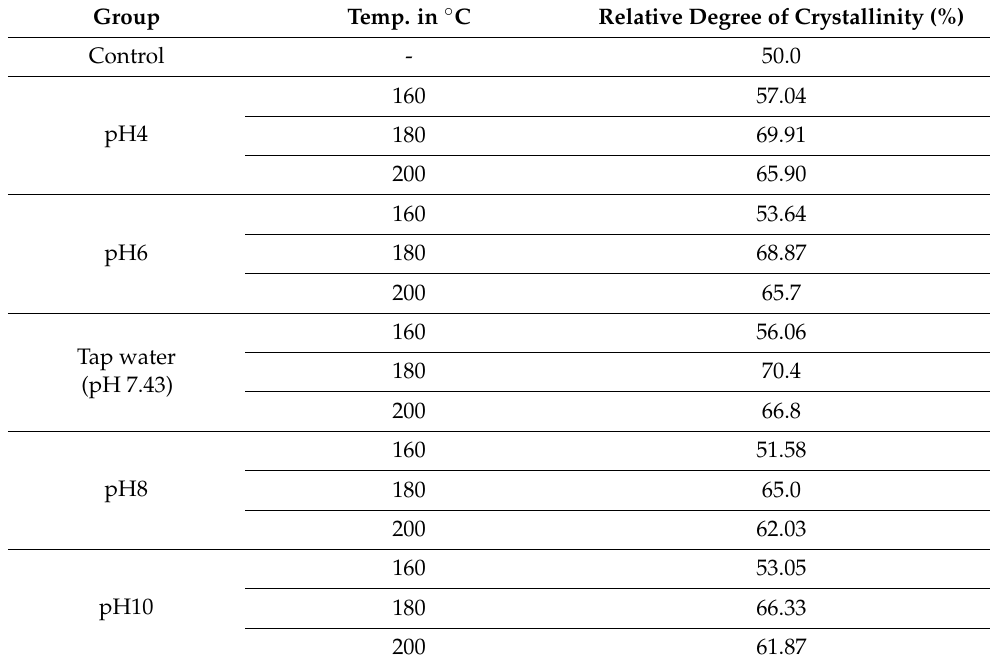
Table 2. The relative degree of crystallinity of untreated and treated rubberwood. Group Temp. in ◦